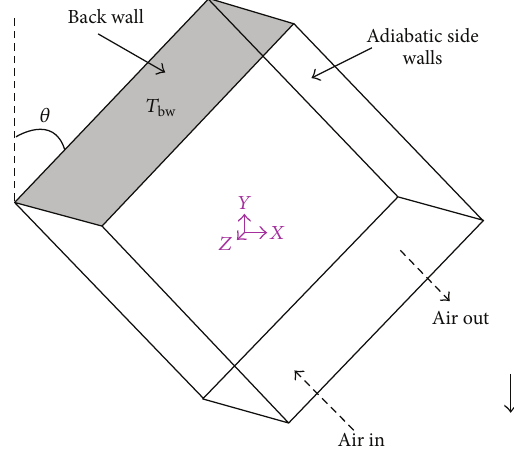
Figure 1: Schematic of the open cubical cavity inclined downwards at an angle 𝜃